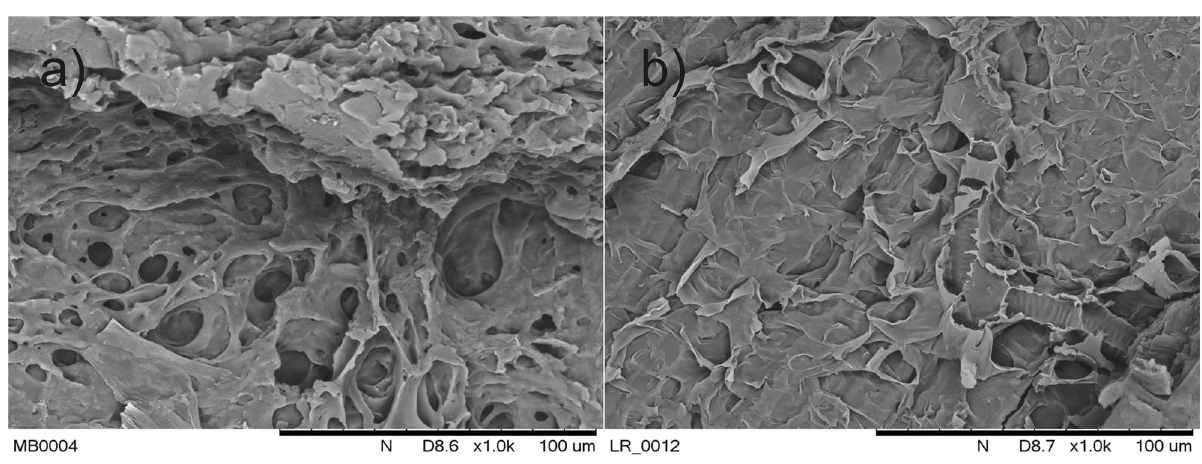
Figure 6. Surface structure of BSG ( a ) and P-BSG ( b